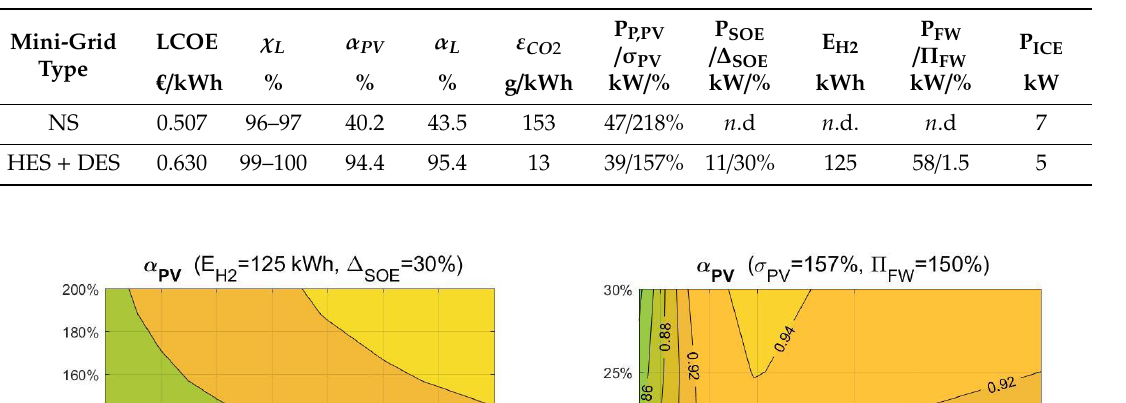
Table 2. Energy and environmental performance optimization: NS (Basic PV-Diesel mini-grid) and